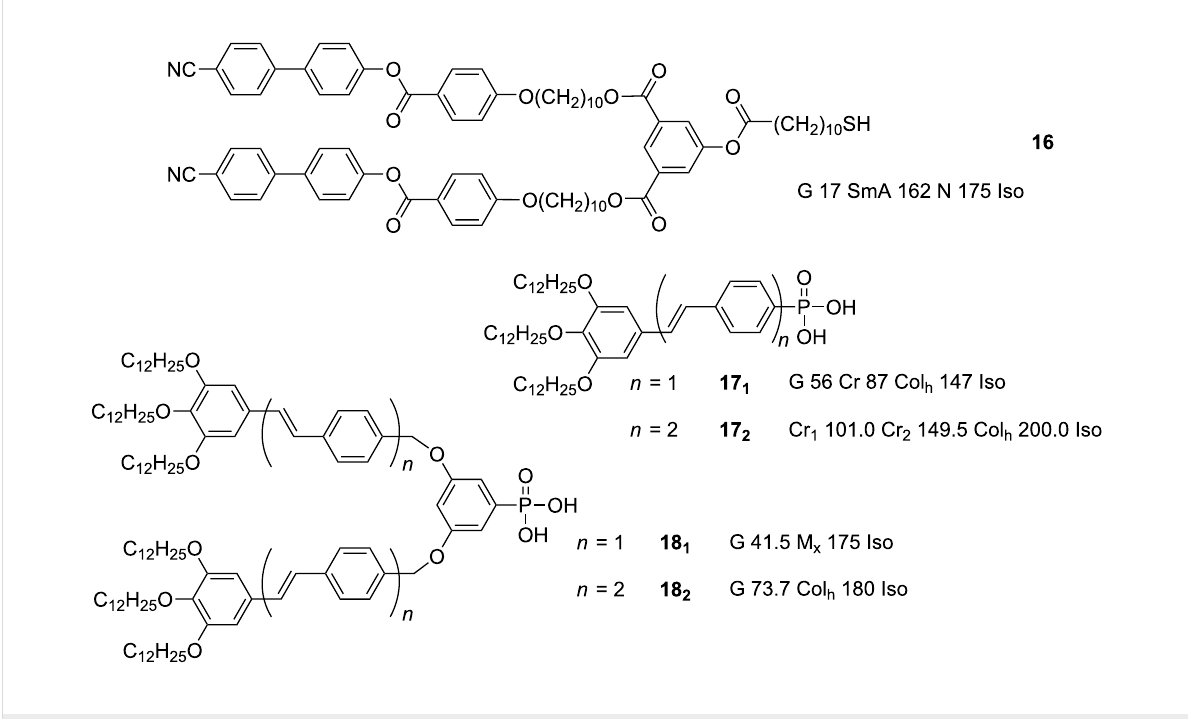
that the hybrids are highly anisotropic in shape, either from ligand migration on the surface to the poles of the NPs, and/or through a significant orientational bias of the ligands away from the particle equators towards the poles.